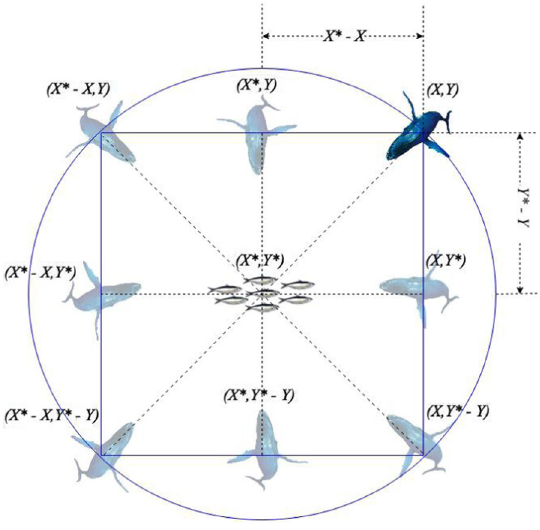
Fig. 2 The principle of prey encircling technique used by humpback